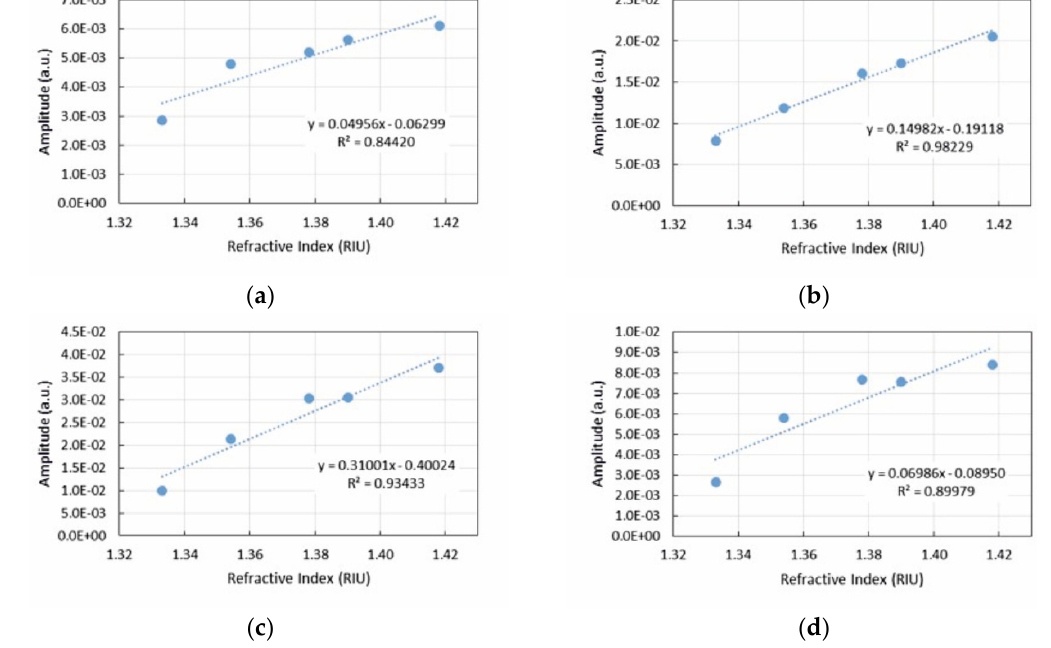
Figure 9. Calibration curves for the FP-short sensor ( L 1 = 105 µm and L 2 = 149 µm) using spectral analysis and considering Peaks (a) 1, (b) 2, (c) 3, and (d) 4 with regard to Figure 8b.